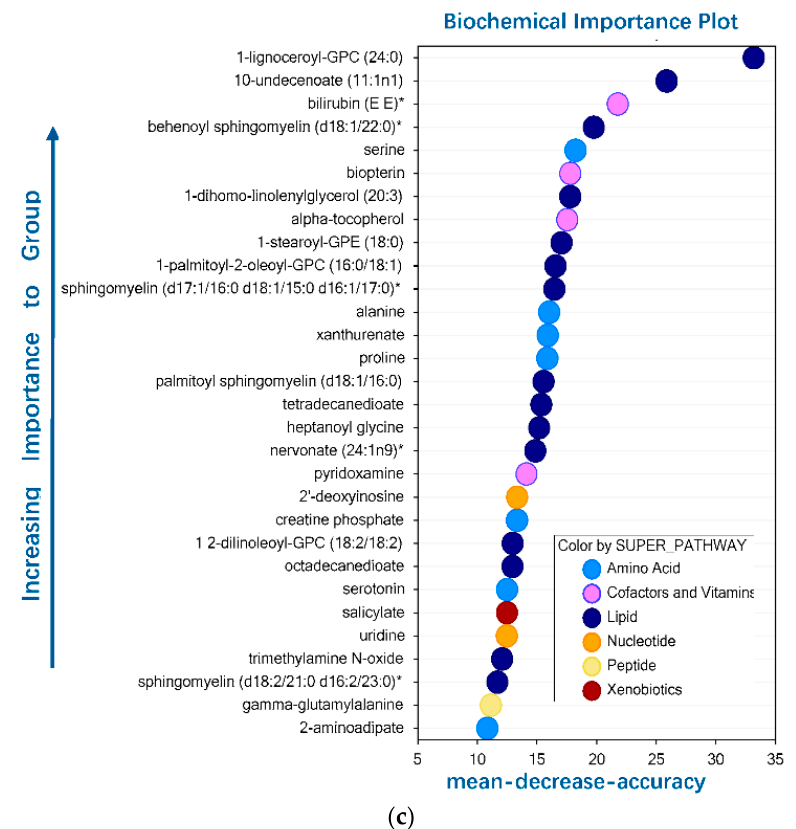
Figure 1. ( a ) Principal component analysis (PCA) showed differences in metabolites of serum sam- ples in mice between the control HFD group and the treatment HFD+TT800 group. Each ball rep- resents the cumulative metabolites from each mouse. The 10 orange balls are mice from the control HFD group and 10 blue balls are mice from the HFD+TT800 group. Metabolites associated with mice in the TT800 group are more tightly associated or closer together than those from mice in the control HFD group. TT supplementation appears to narrow the range of metabolite data in the mice fed the HFD. Each dietary group was comprised of n = 10 mice. ( b ) Differences in eight